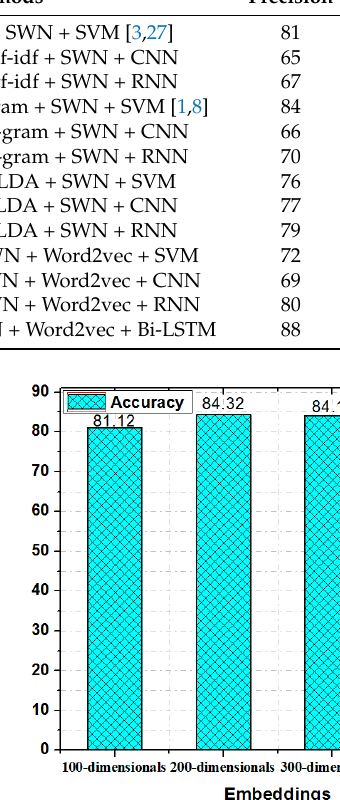
Figure 8. Accuracy of different embedding dimensional.